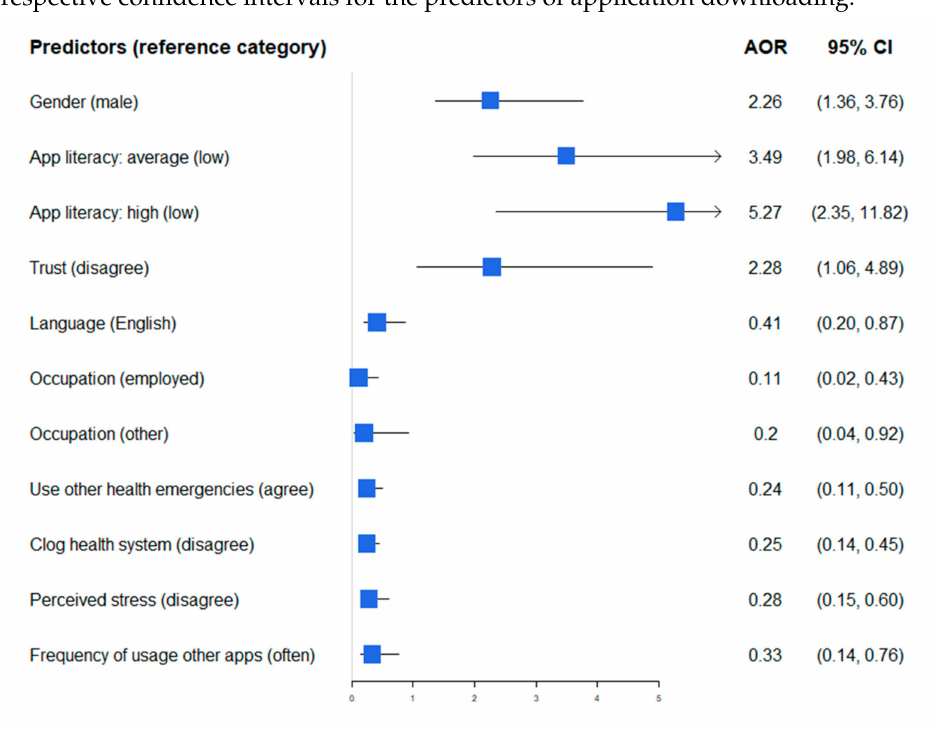
Figure 2. Download predictors of the COVID Alert app. Abbreviations: AOR, adjusted odds ratio; CI, confidence